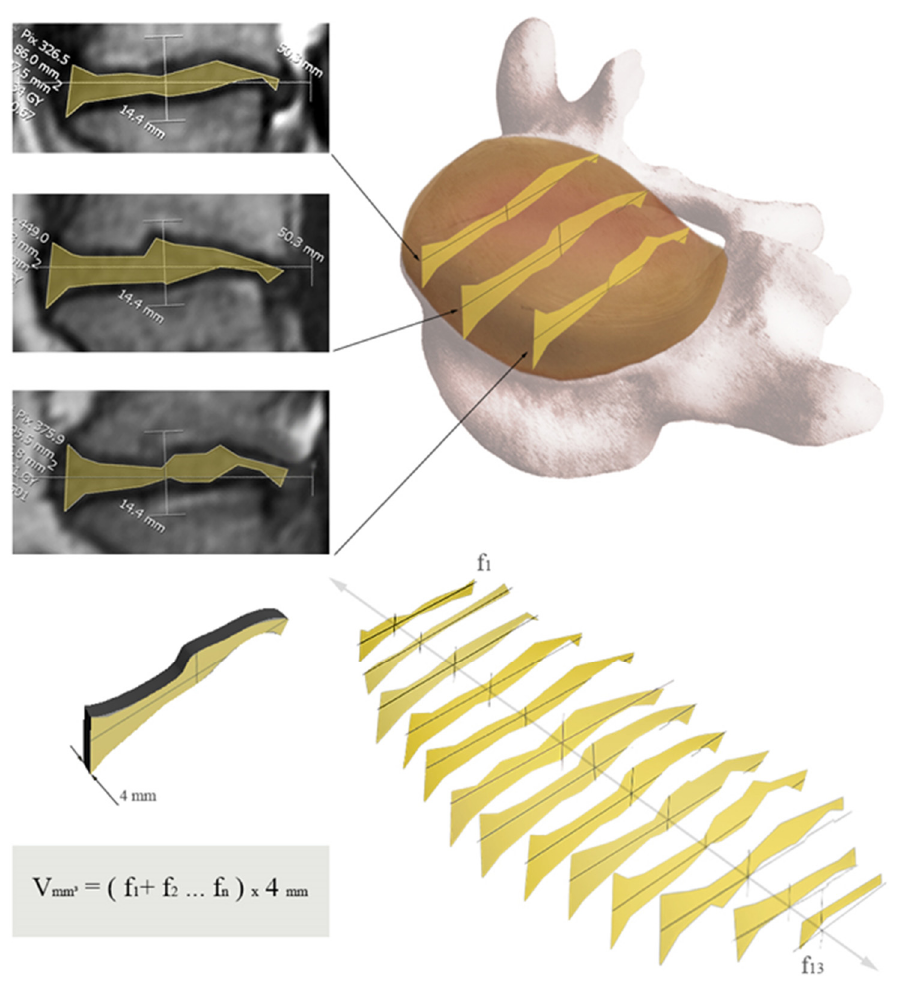
Figure 3. Schematic depiction of the disc volume measurement. The disc areas are measured in all sagittal layers of the MRI. To obtain a volume, the areas are summed and multiplied by the layer thickness of the scans (4 mm).